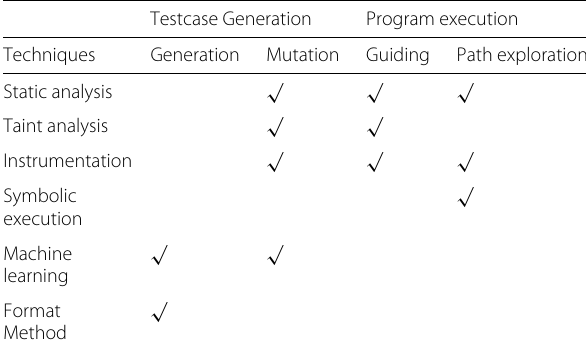
Table 5 Techniques integrated in